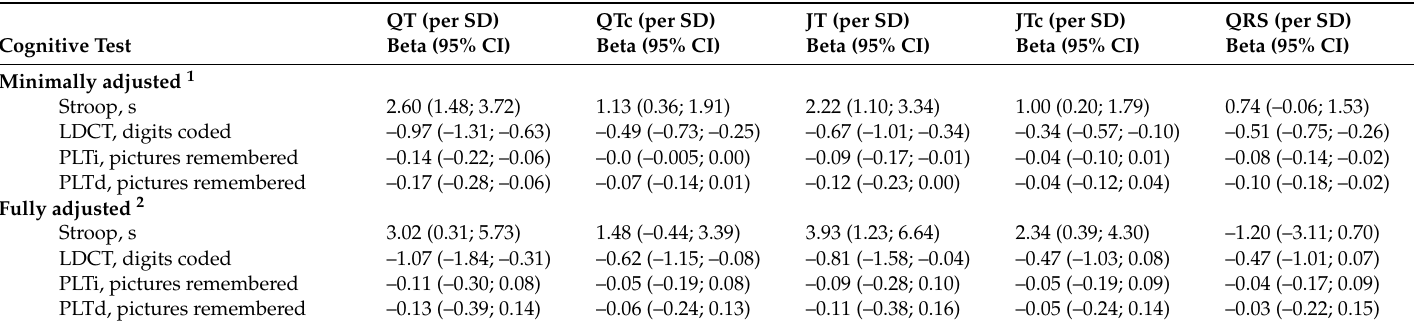
Table 2. Cross-sectional associations between measures of ventricular de- and repolarization and cognitive function at